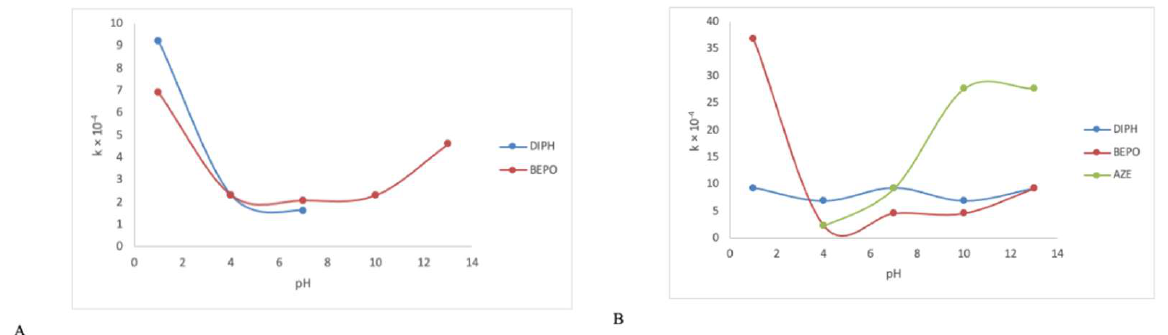
Figure 6 . pH–rate profiles for the degradation of diphenhydramine (DIPH), azelastine (AZE) and bepotastine (BEPO) in solutions under ( A ) thermolytic stress and ( B ) photolytic stress.